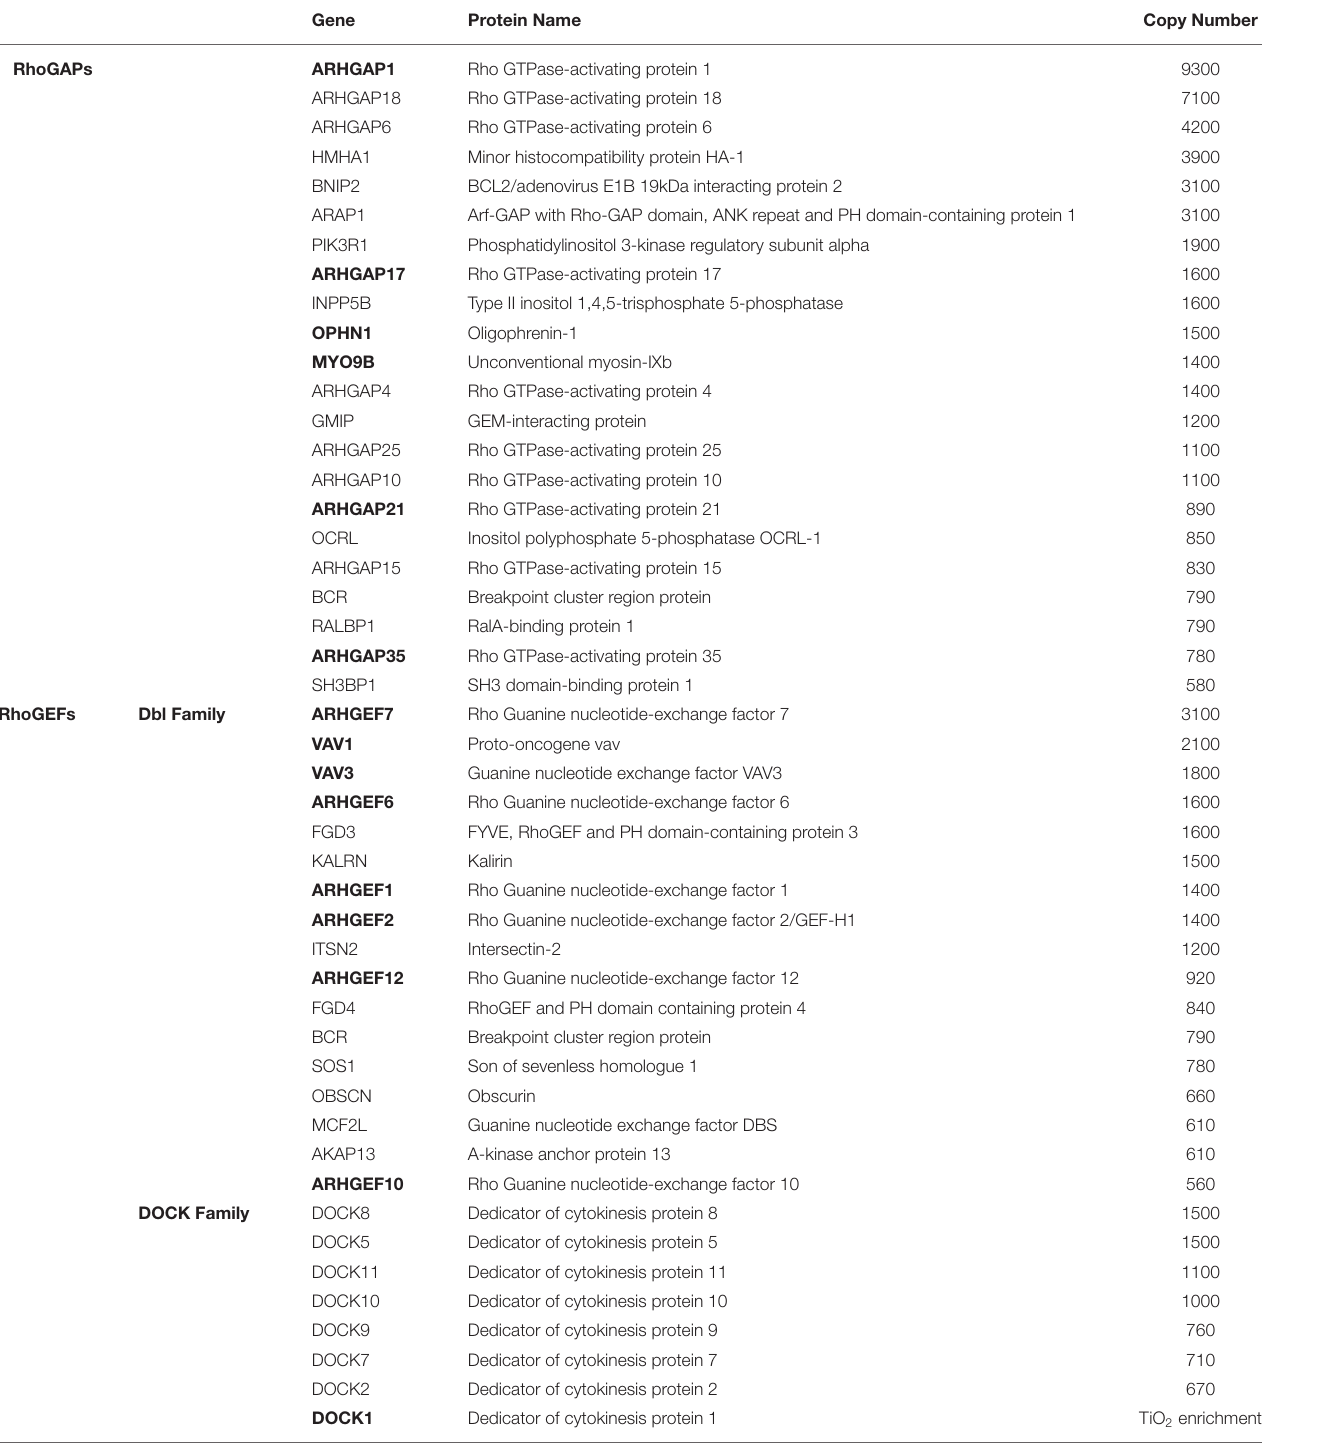
TABLE 1 | Rho GTPase-activating proteins (RhoGAPs) and Rho guanine nucleotide exchange factors (RhoGEFs) expressed in human